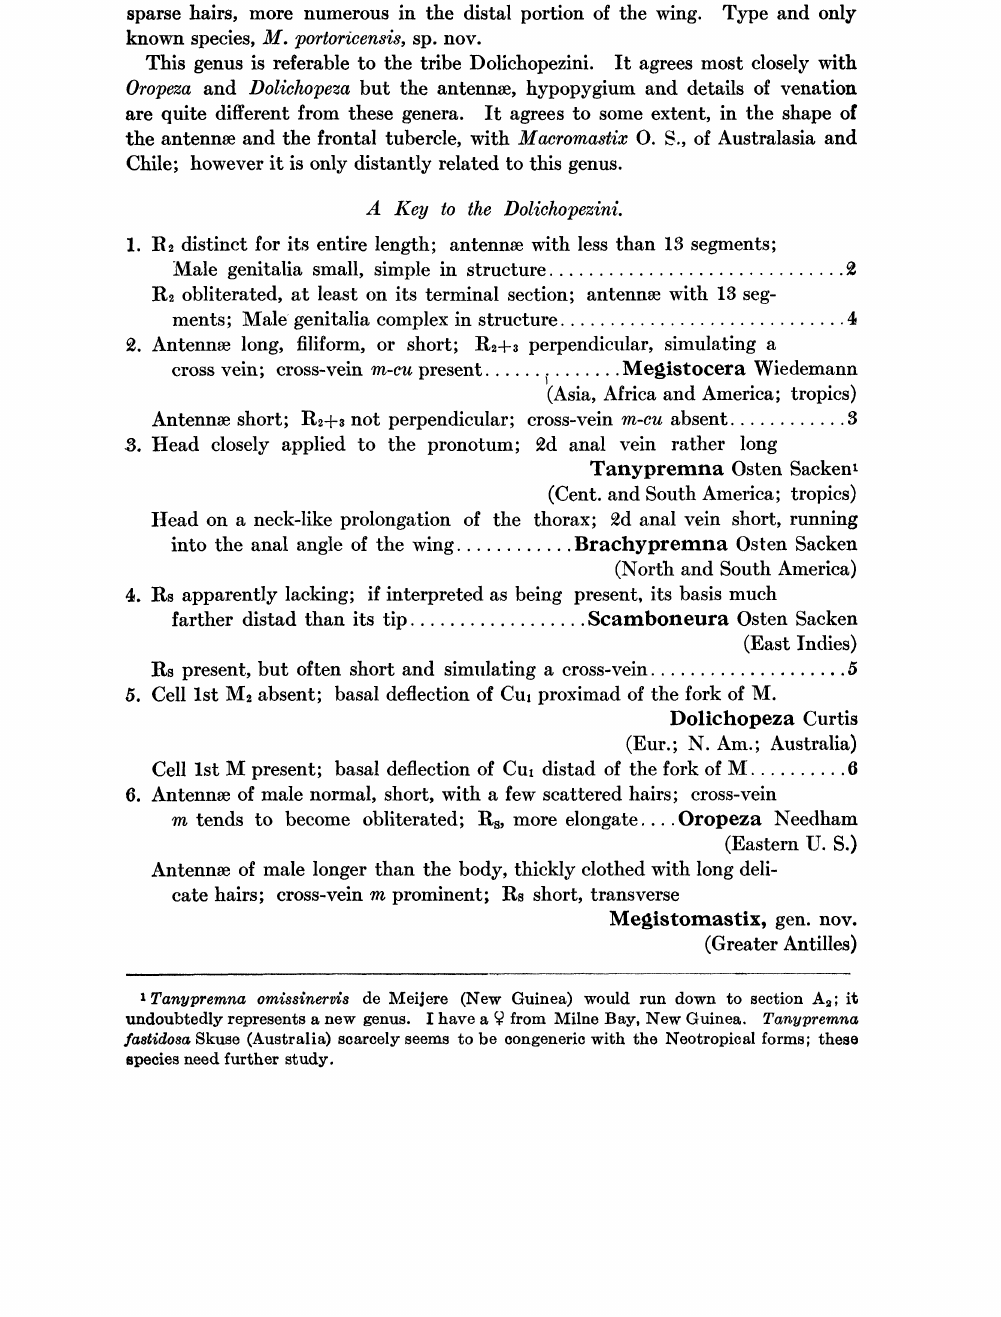
Psyche [April the deflection of R4+. Cell 1st Ms elongate, the sides parallel. M+ beyond the cross-vein m, short, about equal to the cross-vein r-re. Cul meets Ms at a point, barely obliterating the cross-vein m-cu. Cell Cu, broadest basally as in the Tipu- line, Cu being gently situnaed; d A rather short. Cells of the wings with sparse hairs, more numerous in the distal portion of the wing. Type and only known species, M. portoricensis, sp. nov. This genus is referable to the tribe Dolichopezini. It agrees most closely with Oropeza and Dolichopeza but the antennae, hypopygium and details of venation are quite different from these genera. It agrees to some extent, in the shape of the antennae and the frontal tubercle, with Macromastix O. S., of Australasia and Chile; however it is only distantly related to this